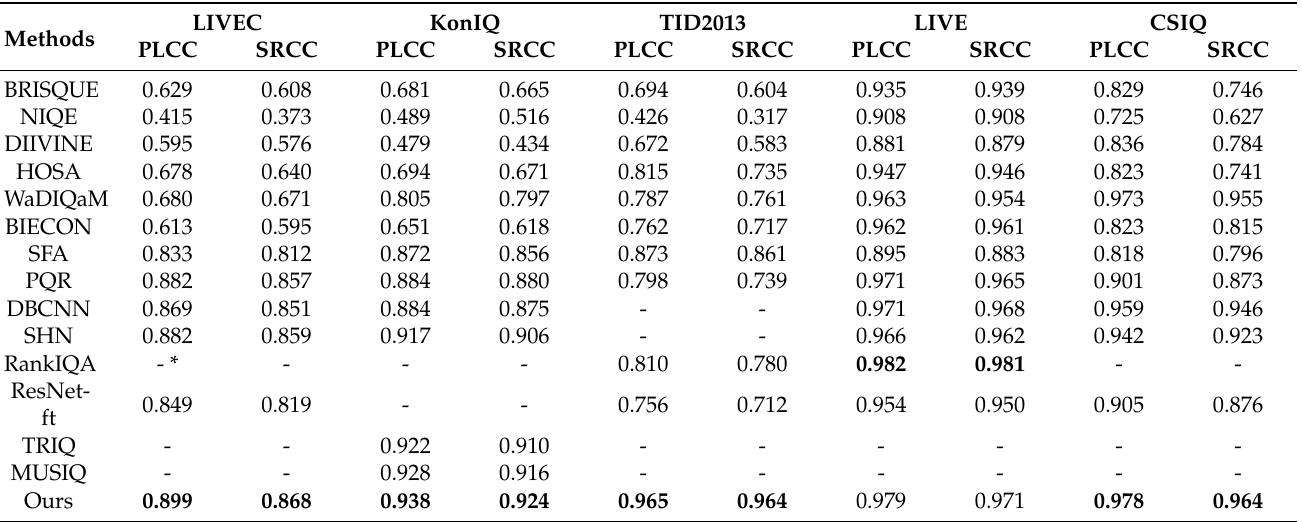
Table 2. Performance comparison of the IQA methods on five standard IQA databases, i.e., LIVEC, KonIQ, TID2013, LIVE, CSIQ. The top-performing method is highlighted in boldface.